Question: According to this chart, does the measure grow or shrink?
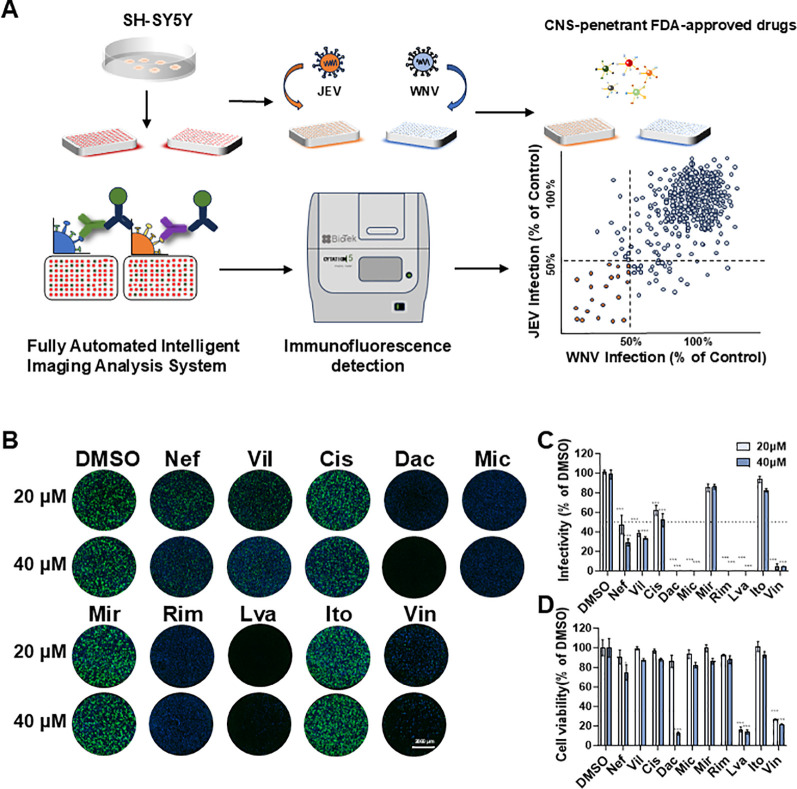
Answer: increasing